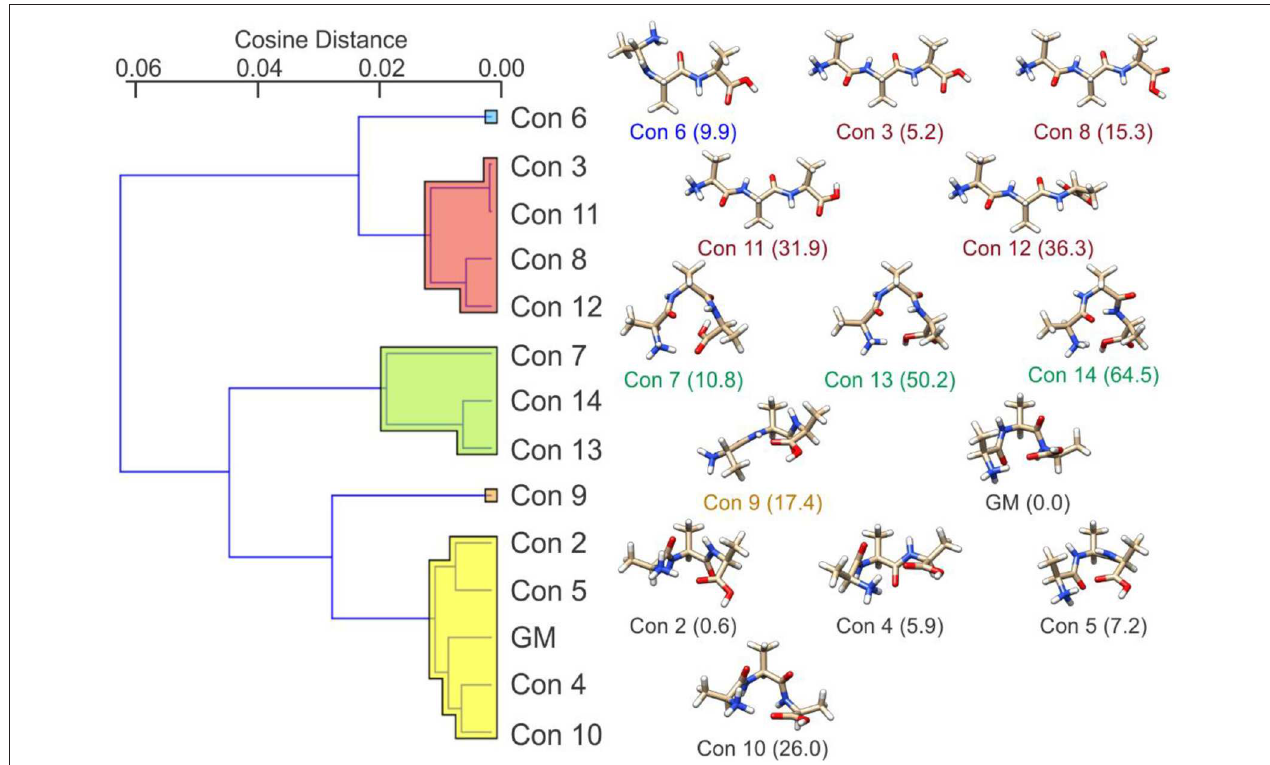
FIGURE 8 | (Left) The cosine distance dendrogram for protonated alanine tripeptide, [AAA (kJ mol − 1 ; in parentheses). Calculations were conducted at the B3LYP/6-311 Conformers are numbered in order of increasing energy relative to that of the global minimum (GM)